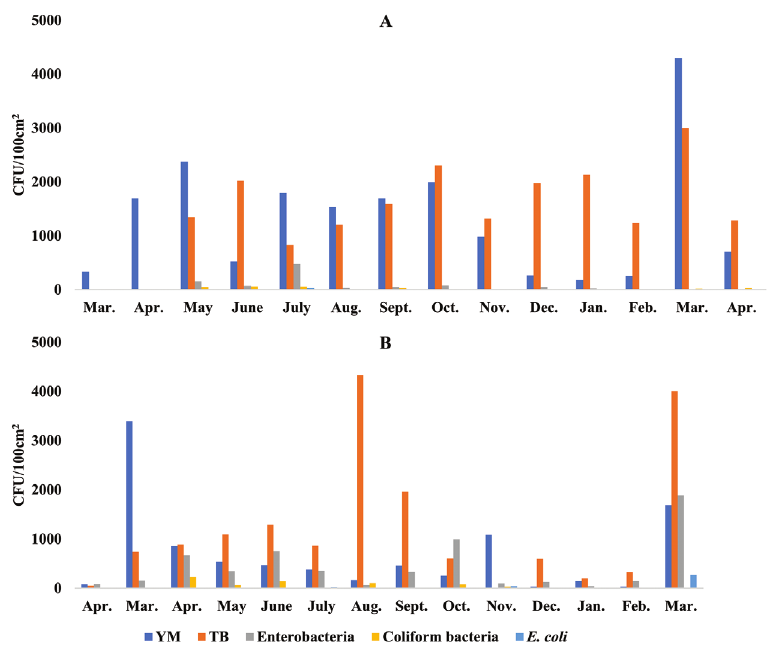
Figure 3. Distribution of culturable bacterial and fungal abundances on the Ursus spelaeus skeletons on display from 2015 to 2016 in Ursilor ( A ) and Muierilor ( B ). TB, total aerobic bacteria; YM, yeasts and moulds; E. coli , Escherichia coli